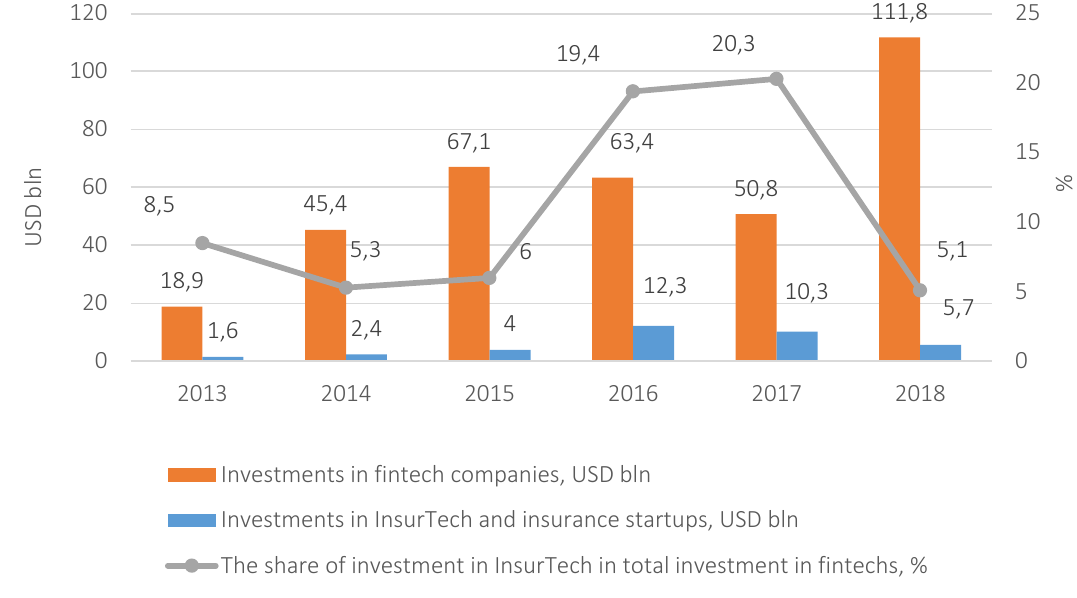
Figure 1. Dynamics of investment in fintech companies and